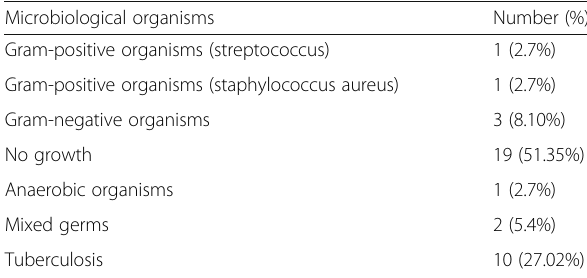
Table 2 Microbiological diagnosis of pleural fluid in studied patients ( n = 37)